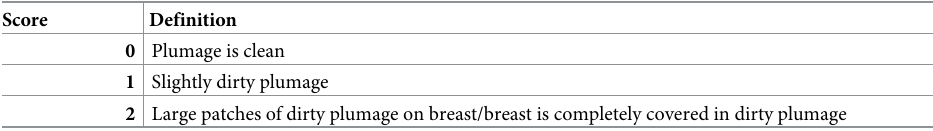
Table 3. Breast cleanliness feather score and descriptions a